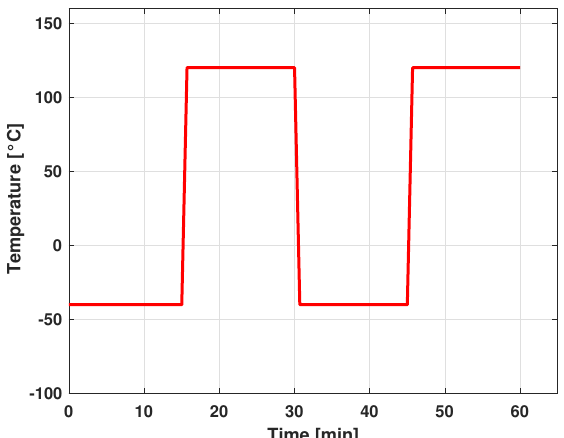
Figure 3. Thermal profile of the Thermal Cycling Test (TCT), which the circuits were subjected